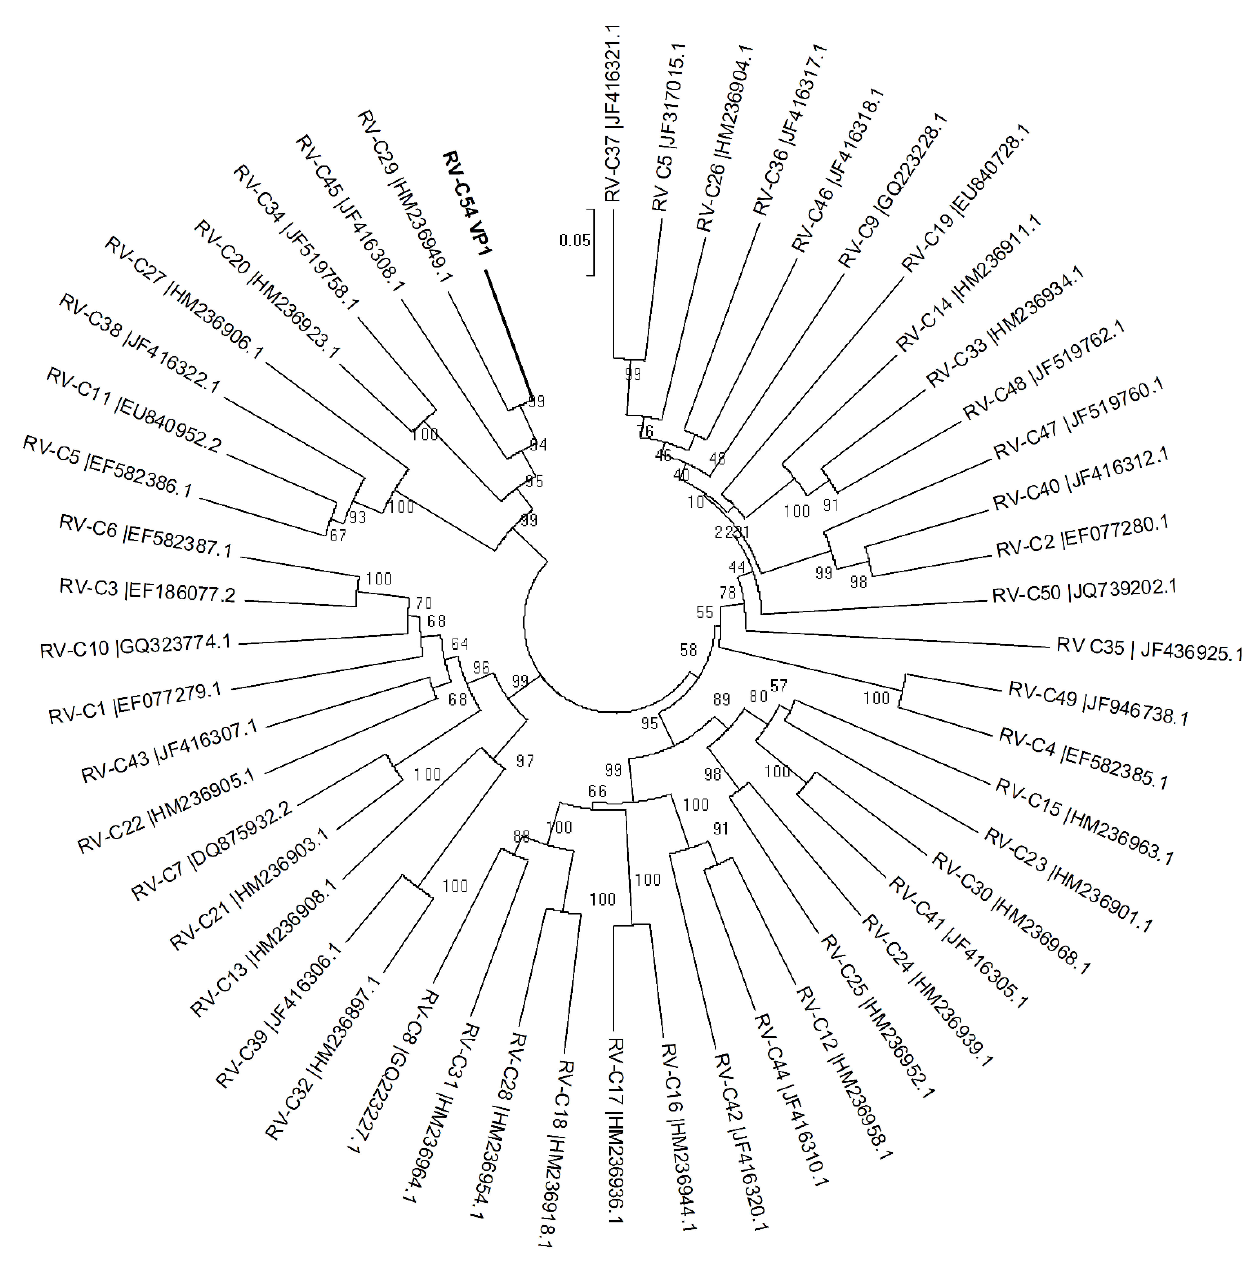
Figure 2. Phylogenetic tree based on nucleotide sequences of the VP1 gene. The neighbor-joining tree (Maximum Composite Likelihood model) was evaluated by 1000 bootstrap pseudo-replicates. RV-C54 is indicated in